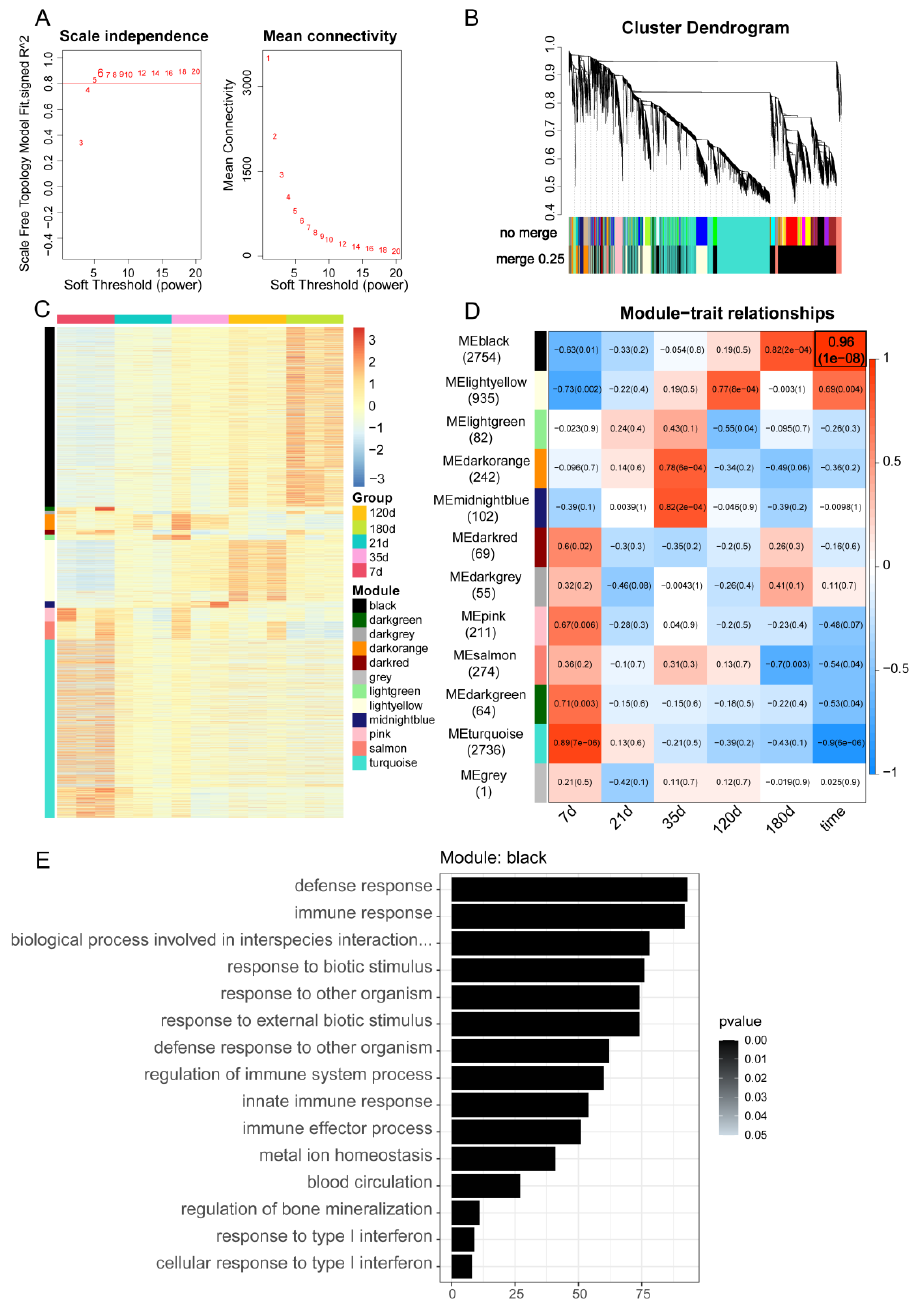
Figure 4. WGCNA of mRNA and lncRNA dataset identified gene co-expression module at different time points. ( A ) Selection of the soft-thresholding powers ( β ). The scale-free fit index in relation to soft-thresholding power was displayed in the left panel. The mean connectivity vs soft-thresholding power was shown in the right panel. The fit index curve for power 6 was chosen because it flattens out at high value (>0.8). ( B ) Hierarchical cluster dendrogram of spleen samples in different time points showing co-expression modules generated using WGCNA. Modules belonging to branches are color-coded according to the interconnectedness of genes. 12 modules represented by colors in the horizontal bar were found using 0.25 threshold merging. ( C ) Heatmap showing gene expression of 12 modules across five time points. ( D ) Relationship between modules and traits. Each column denotes a trait, and each row denotes an eigengene for a certain module. The matching correlation and p value are included in each cell. ( E ) GO enrichment analysis of mRNAs from the black module. The bar chart displays the top 15 highly enriched biological processes, ordered by p